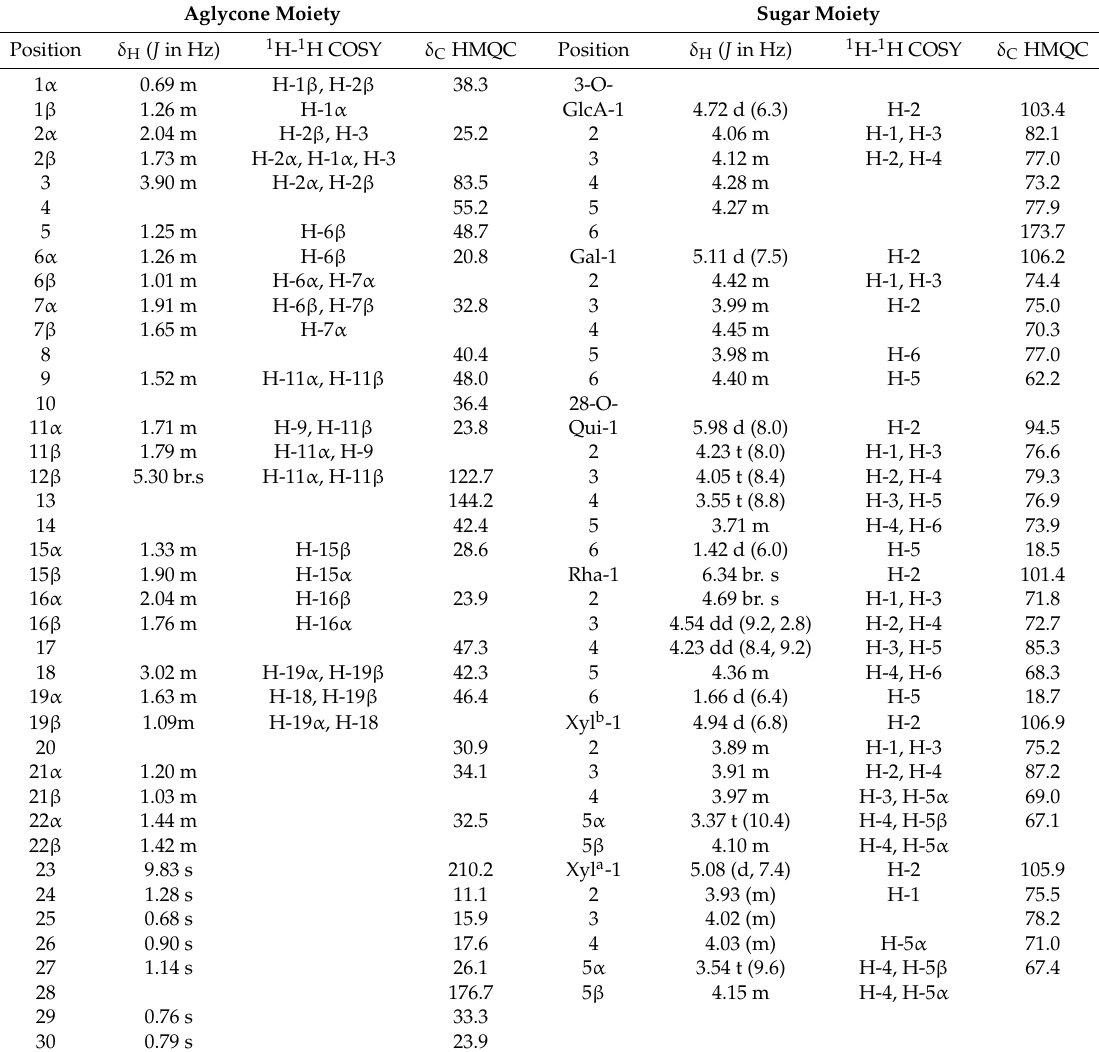
Table 1. The spectral data of 1 H-NMR (400 MHz), 13 C-NMR (100 MHz), and 2D-NMR of 1 H- 1 H COSY and HMQC of compound 1 in C 5 D 5